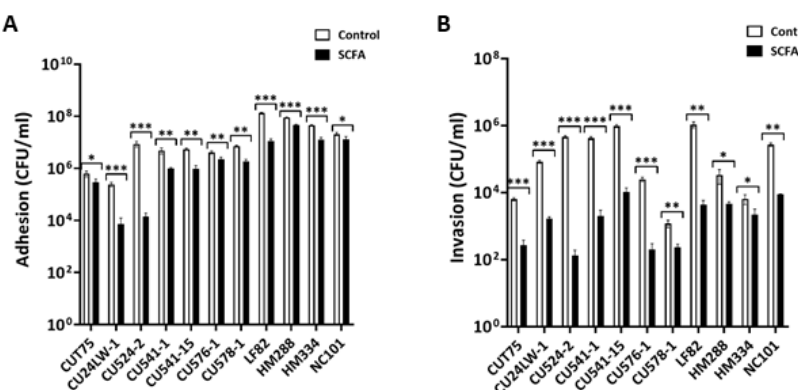
Figure 7. c-SCFA inhibit E. coli adhesion and invasion of intestinal epithelial cells. Overnight culture of E. coli was added to the monolayer of intestinal epithelial cells (Caco-2) in the presence of 65 mM NaCl (Control) or SCFA at pH = 6.5. The number of adherent or invasive E. coli were determined by quantitative plating method (see Methods). ( A ). Adhesion to Caco-2 cells; ( B ). Invasion of Caco-2 cells. Data from three independent experiments; Mean ± SD. * p < 0.05; ** p < 0.01; *** p < 0.001.